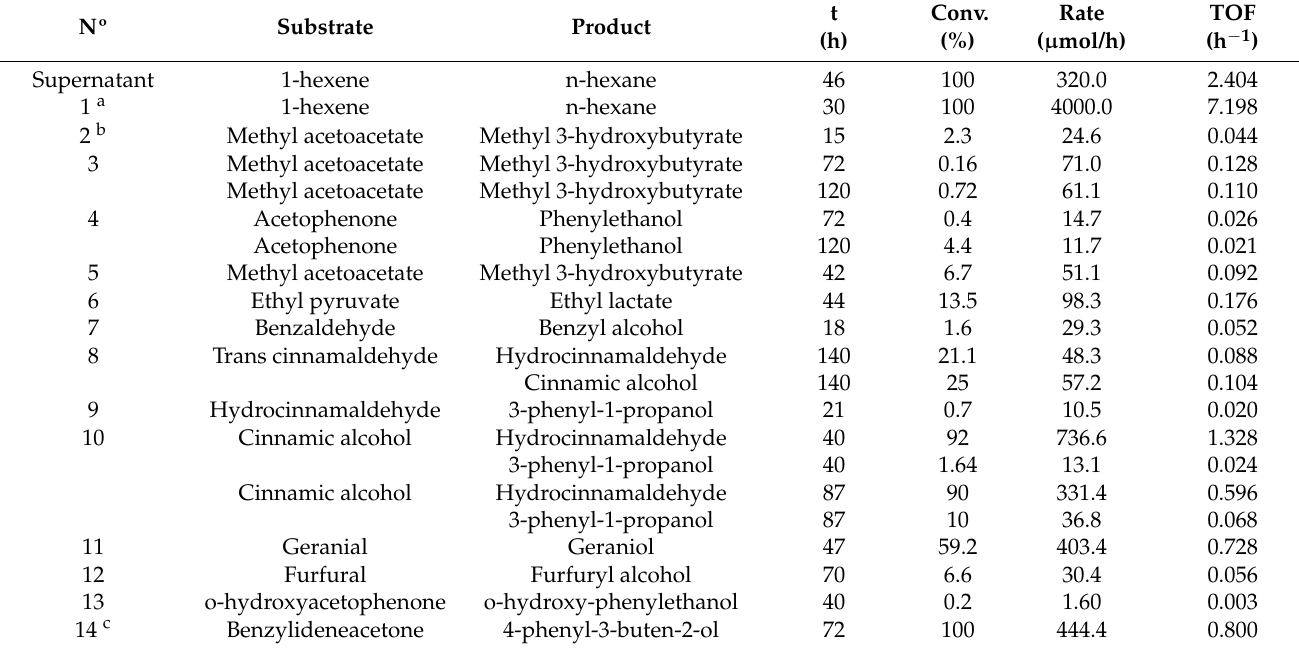
Table 4. Successive hydrogenation rates obtained with 0.4718 g of the complex [Ru II Cl(bpea)(DPPE)}](BF 4 ) covalently attached to 3.4 g of AlPO 4 –Sepiolite, 0.032 mol of different substrates at different reaction times in 40 mL of methanol as solvent, at 50 ◦ C of reaction temperature and 90 atm of initial hydrogen